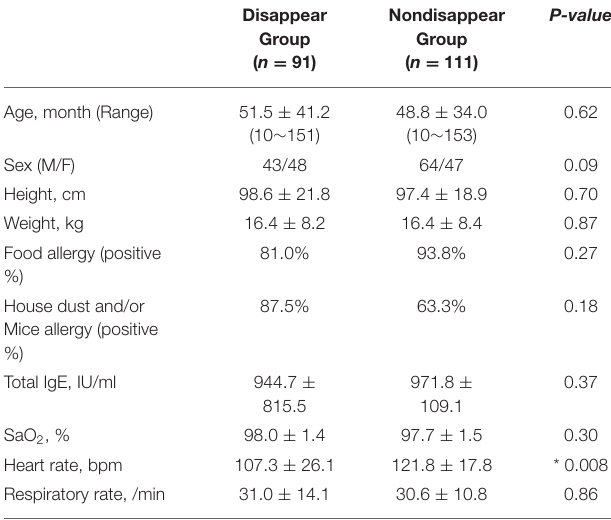
TABLE 1 | Participants’ characteristics and respiratory statuses of the two